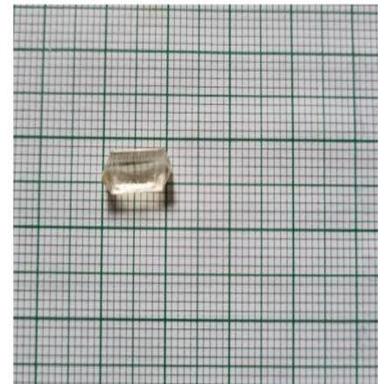
(a) and (b) G4C3NBM crystal.